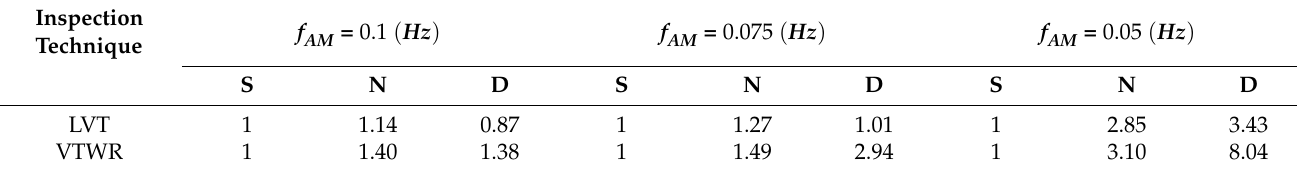
Figure 7. Inspection of the impact side of the CFRP sample at various AM frequencies: ( a , d , g ) 0.1 kHz, ( b , e , h ) 0.075 kHz and ( c , f , i ) 0.05 kHz. The top and the middle rows present the surface maps of Peak χ resulting from LVT and VTWR, and the bottom row displays the CNR values of regions S, N and D calculated for both techniques. The color bars indicate the contrast with the sound area S. With this definition, a CNR value < 1 indicates that the area of interest cannot be discerned from noise. The CNR values for both VTWR and LVT are given in Figure 7g–i and listed in Table 1. Table 1. CNR values of Peak χ calculated for both LVT and VTWR